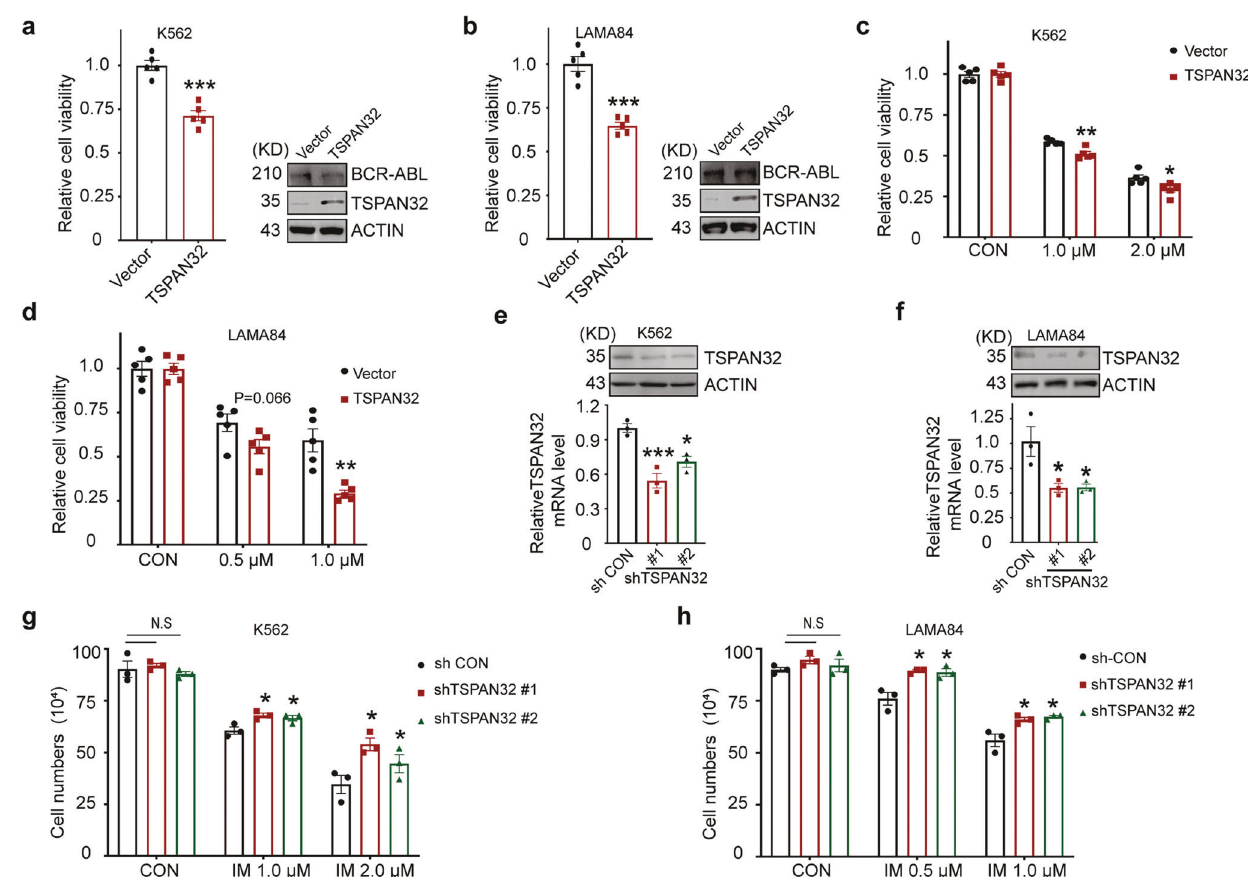
Fig. 2 Overexpression of TSPAN32 synergizes with Imatinib for the inhibition of CML cell line growth. a , b K562 and LAMA84 cells with or without ectopic expression of TSPAN32 were seeded in 96 well plates for 48 h. Cell viability was measured with CCK8. Relative cell viability was normalized to control cells. The expression statuses of TSPAN32 and BCR-ABL were also examined and shown. ACTIN served as sample loading control. c , d K562 and LAMA84 cells with or without ectopic TSPAN32 expression were seeded in 96 well plates and treated with Imatinib at indicated concentration for 48 h. Cell viability was measured with CCK8. Relative cell viability was standardized with respective control cells. e , f The knockdown ef fi ciency of shRNA targeting TSPAN32 in K562 and LAMA84 cells were examined with RT-PCR and immunoblotting. g , h K562 and LAMA84 cells with or without shRNA targeting TSPAN32 were plated and treated with Imatinib at the indicated concentration for 48 h, living cells were counted. Error bars denote mean ± SEM, * P < 0.05, ** P < 0.01, *** P < 0.001 ( T